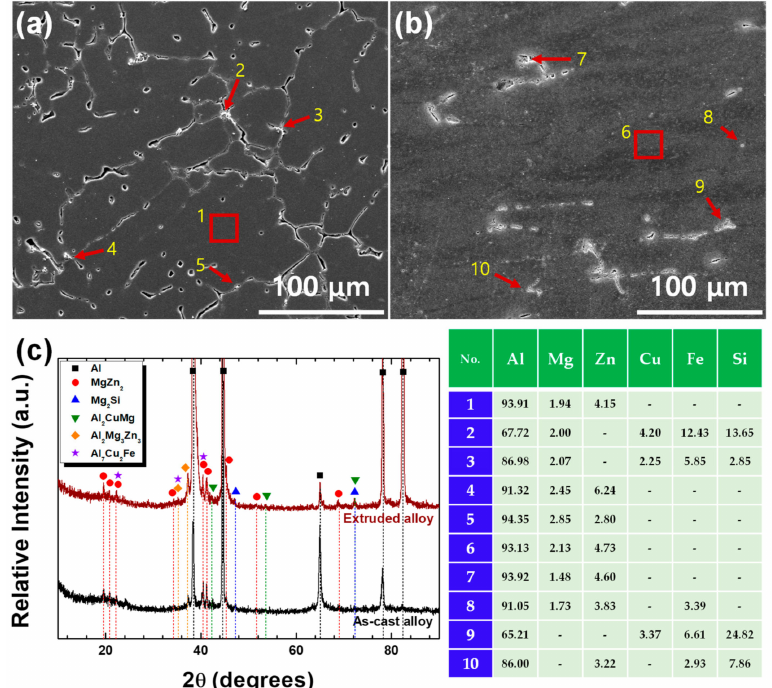
Figure 2. The SEM micrographs of the ( a ) as-cast and ( b ) extruded alloys. ( c ) The XRD curves for the as-cast and extruded alloys. The inserted table represents the energy dispersive X-ray spectroscopy (EDS) analysis